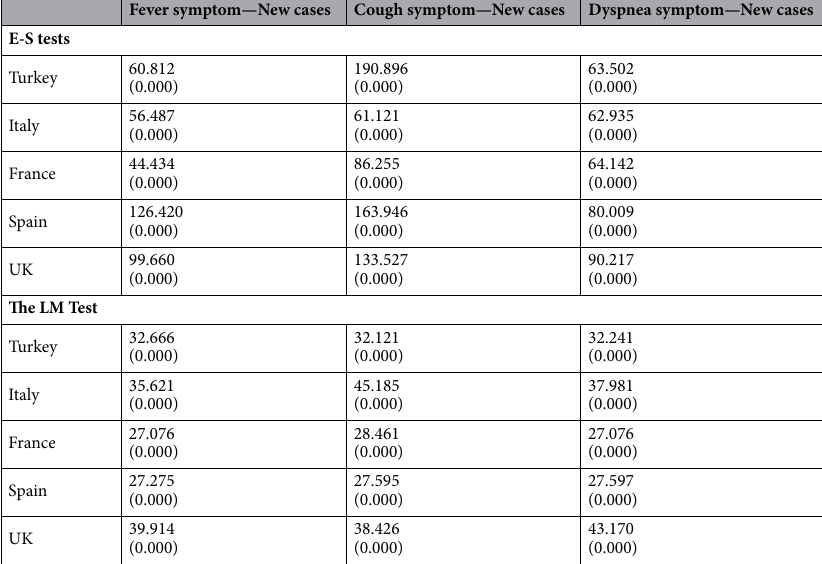
Table 3. Diagnostic checks of the DCC model. E-S Test (j) ~ χ 2 (j+1) and LM test ~ (j) ~ χ 2 (N*+(N-1)/2)) under H 0 : Constant correlation, H 1 : Dynamic correlation. p-values are shown in parentheses.